Question: What style of plot is this figure drawn as?
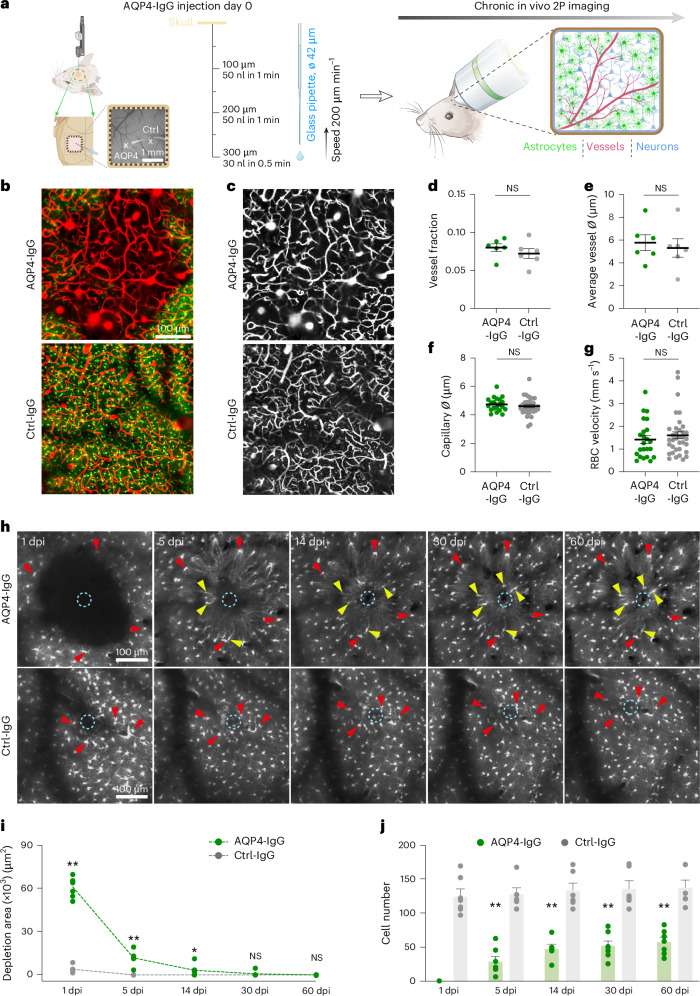
Answer: line